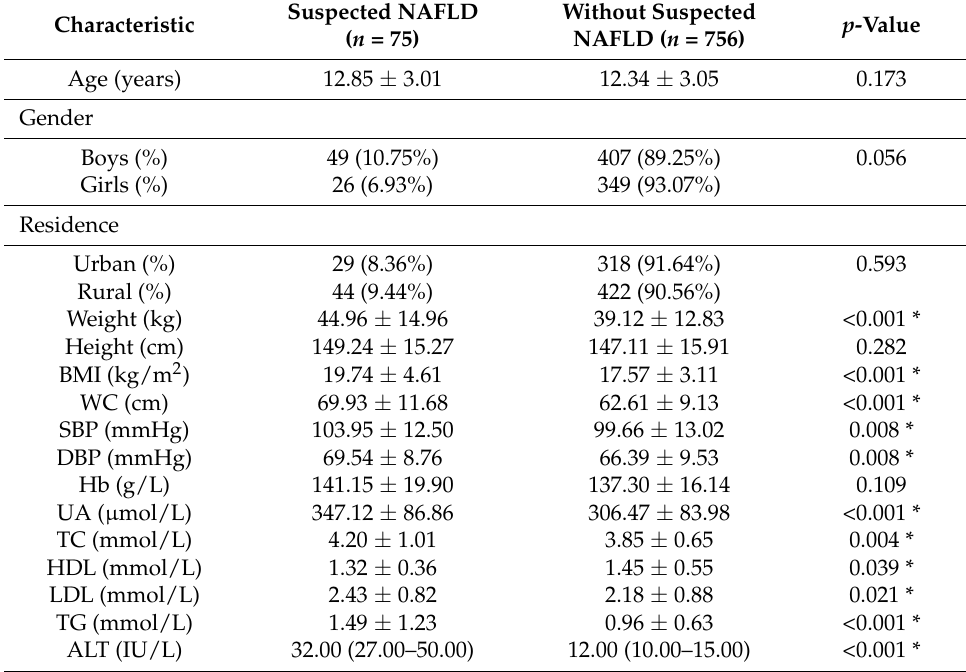
Table 2. Basic characteristics of children with and without suspected NAFLD.